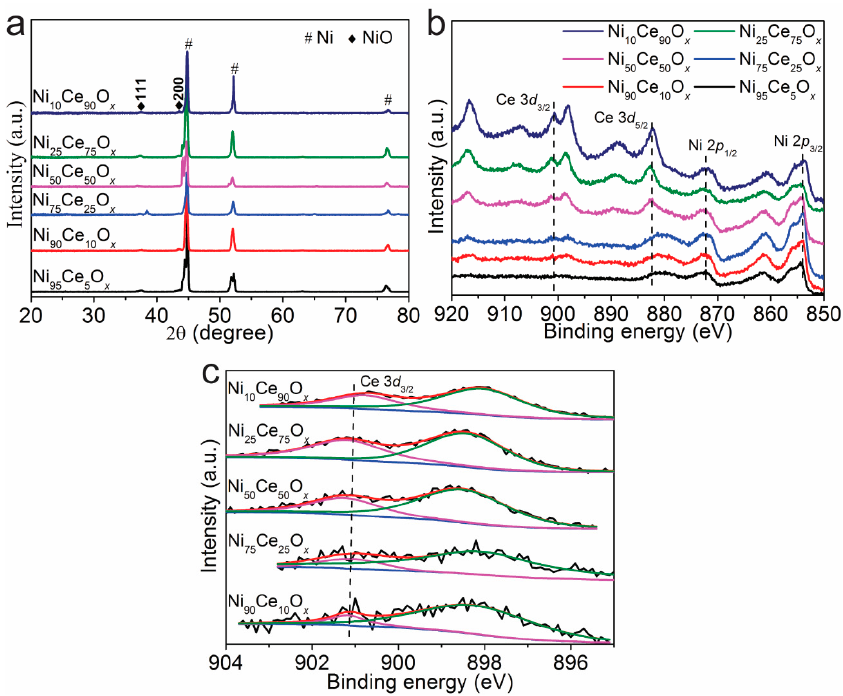
Figure 2. ( a ) X-ray diffraction patterns and ( b , c ) XPS spectra of Ni y Ce 100- y O x samples. Two Raman peaks of 224 cm − 1 and 563 cm − 1 were observed for Ni 75 Ce 25 O x , Ni 50 Ce 50 O x , Ni 25 Ce 75 O x and Ni 10 Ce 90 O x samples, as shown in Figure 3a. For Ni 95 Ce 5 O x and Ni 90 Ce 10 O x samples, only the peak of 563 cm − 1 was observed. Crystalline CeO 2 is known to have a strong F 2g Raman peak at 464 cm − 1 related to its fluorite structure [19]. The presence of ions with the oxidation states lower than Ce 4+ in the CeO 2 has been shown to induce a Raman band, known as the D band, from 500 to 700 cm − 1 [19–21]. This band is associated with the presence of oxygen vacancy defects created in the non-stoichiometric CeO 2- y by the 3+ coordinated ions. In addition to the introduction of the D band, the F 2g band will be weakened and becomes asymmetric and broad [22]. In the Raman spectra of the Ni y Ce 100- y O x samples, there is no F 2g band, which suggests that there is no crystalline CeO 2 with a fluorite structure in these samples [23]. The broad peak at 563 cm − 1 (D band) indicates the formation of oxygen vacancy defects. The oxygen vacancy defects should be related to the presence of Ce 3+ because of the incorporation of Ni into CeO 2 , as suggested by the literature [19,20,23]. Furthermore, the amorphous structure of Ni y Ce 100 − y O x con- tributes to the broadness of the peak [22,23]. According to the areas of this peak among different Ni y Ce 100 − y O x samples, we can roughly estimate the concentration of oxygen vacancy defects in these catalysts. The peak areas of the D band have been calculated and summarized in Table S2. The peak areas of 563 cm − 1 for Ni 75 Ce 25 O x and Ni 50 Ce 50 O x sam- ples are similar and larger than those of other Ni y Ce 100 − y O x samples, suggesting that these two catalysts own larger concentration of oxygen vacancy defects. The peak at 224 cm − 1 is related to Ce-OH vibrations which are resulted from surface defects. Different types of hydroxyl groups generated by the dissociation of surface adsorbed water and doubly bridging hydroxyl groups on reduced cerium oxide are detected in the Raman spectra